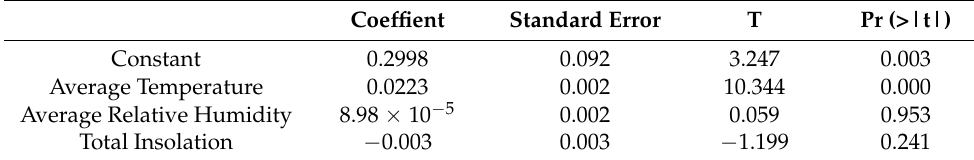
Table 1. Multivariate regression.